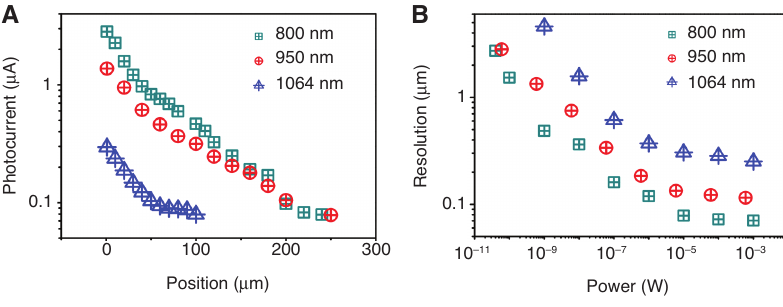
Figure 3: Infrared performance of the PSD. (A) Position dependence of photocurrent of the PSD at infrared light of 800 nm, 950 nm, 1064 nm. (B) The spatial position resolution of the PSD as a function of